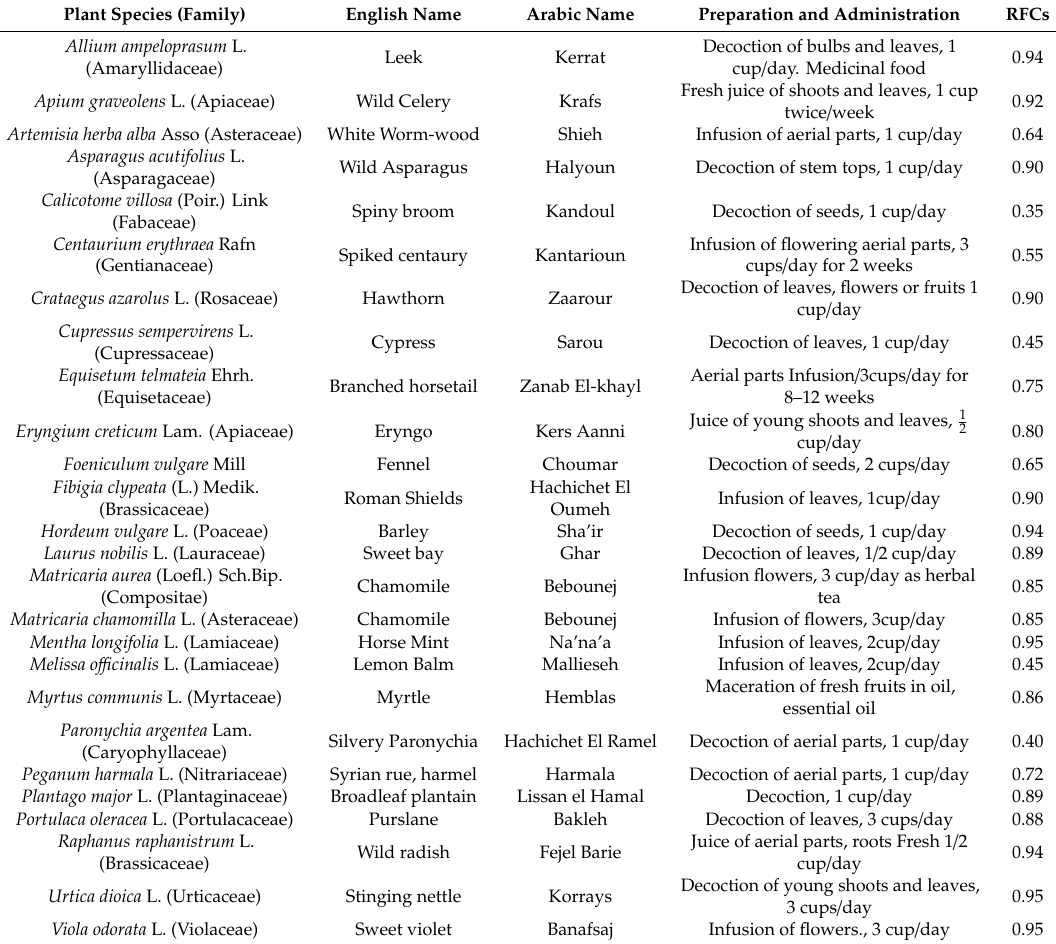
Table 1. Plant species and traditional practices traditionally used for the treatment hypertension (HTN) in